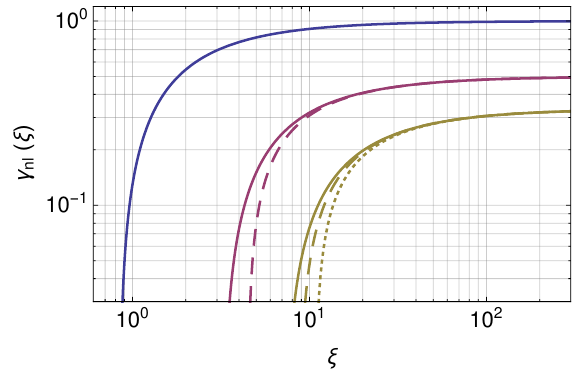
p Figure 13 . (cid:13) n‘ ( (cid:24) ) = (cid:0) 2 (cid:22) E n‘ =(cid:20) , for n = 1 (blue), n = 2 (purple), n = 3 (yellow), and ‘ = 0 (solid), ‘ = 1 (dashed) and ‘ = 2 (dotted), with 0 6 ‘ 6 n (cid:0)